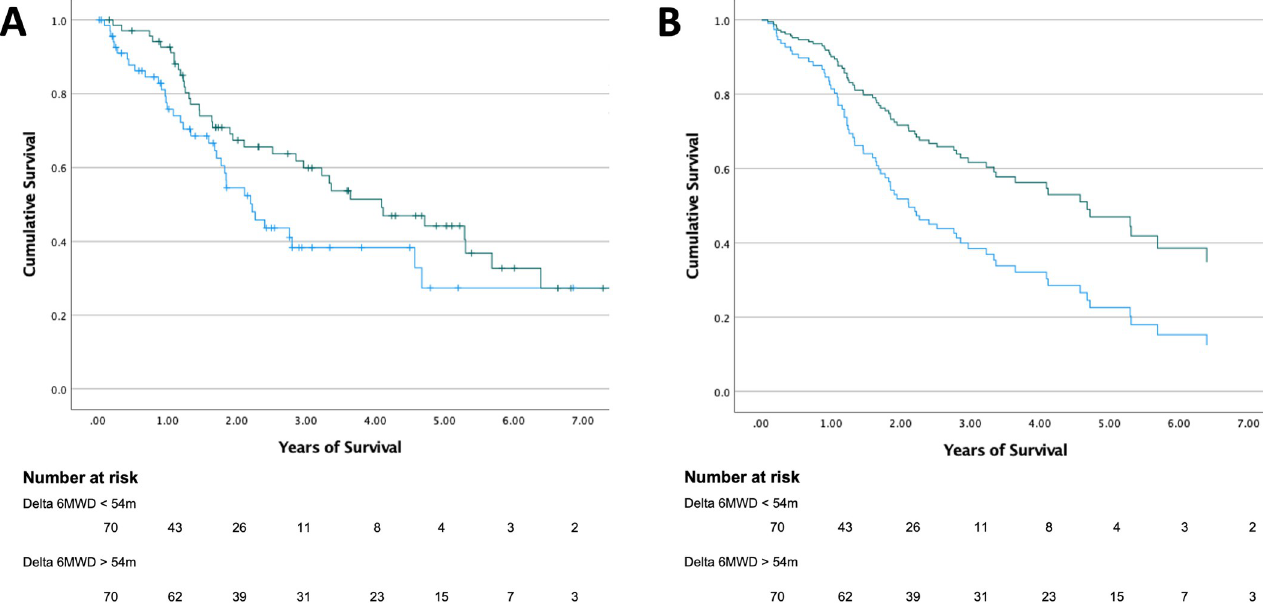
Fig 2. Survival curves between immediate responders and non-responders to oxygen therapy. A. Kaplan Meier estimates of survival. Responders (green line) are subjects who immediately improved their 6-minute walk distance > 54 m when walking on oxygen compared to their baseline distance walked on room air. Non-responders improved < 54 m (blue line). The graphs illustrate time-to-event (death) with a median follow-up time of 3 years. B. Cox regression analysis of survival. The Cox regression model included age, comorbidities (Charlson Comorbidity Index) and FEV1 as covariates. At the time subjects had a lung transplant or developed severe resting hypoxemia after group allocation, they were censored from the analysis. Green line corresponds to responders and blue line to non-responders.